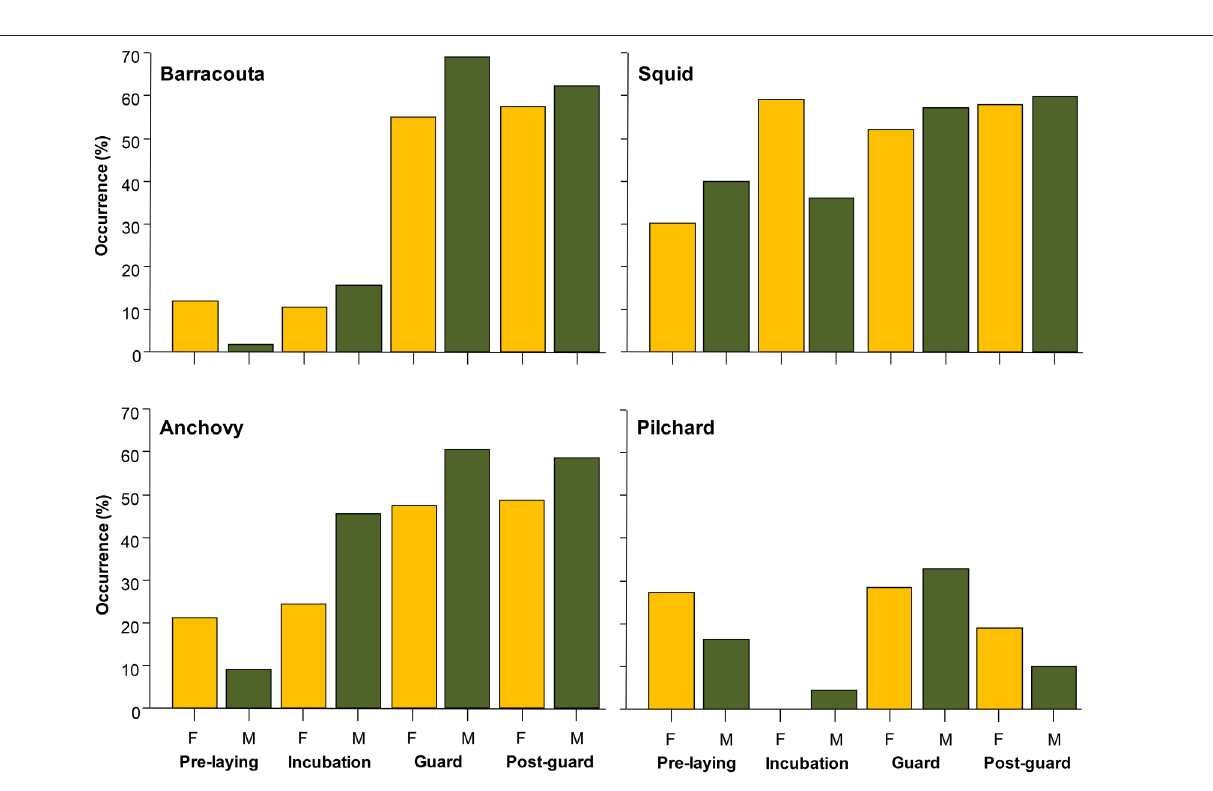
FIGURE 3 | Relative occurrences (%) of key prey types (most important prey species in terms of biomass within stomach contents, i.e., barracouta, squid, anchovy, and pilchard; see Figure 2) split per sex and breeding stage. Relative occurrences were estimated from stomach contents collected during the 1995–2012 (not continuously see Table 1